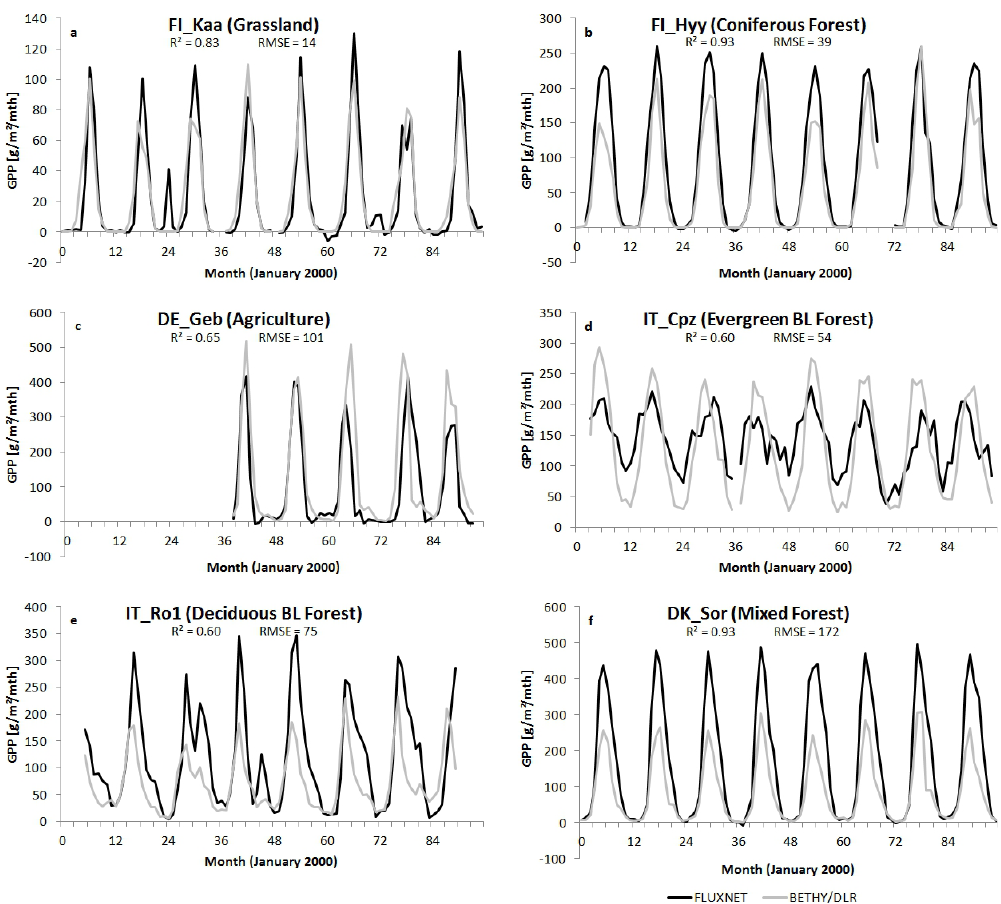
Fig. 3. Monthly sums of GPP for the period January 2000 to December 2007, for six selected FLUXNET stations. Black courses represent FLUXNET measurements, grey courses BETHY/DLR model results. BL stands for